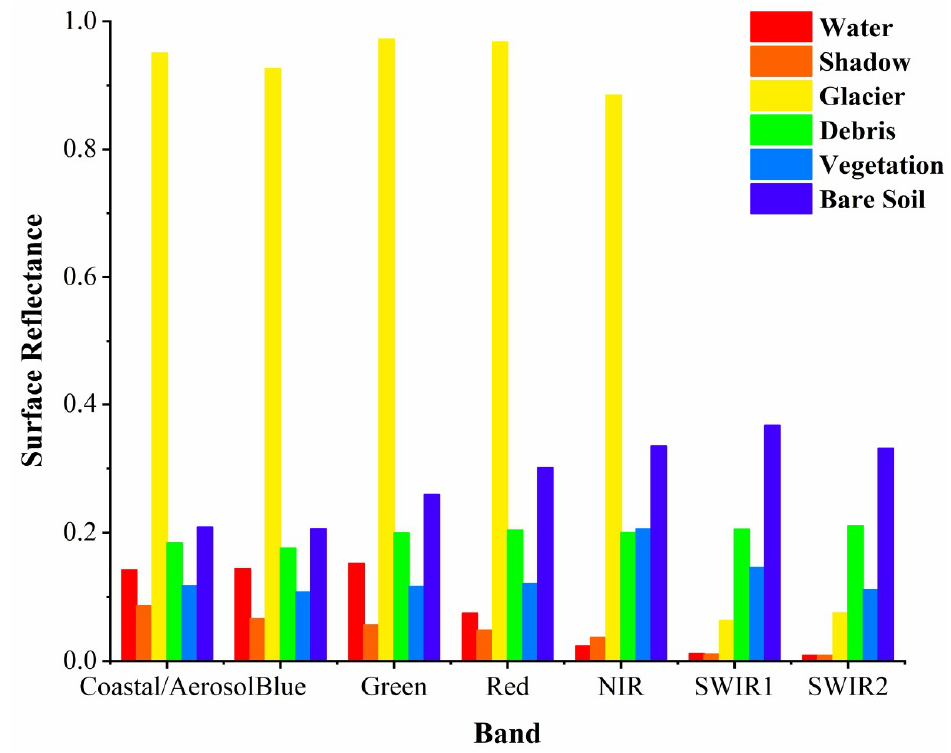
Figure 2. The surface reflectance of six types of surface cover samples in Landsat-8 OLI.